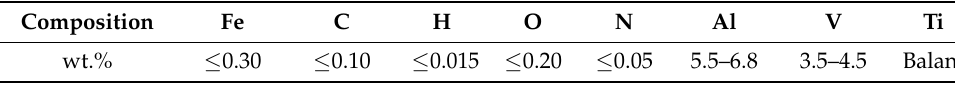
Table 1. Chemical composition of the Ti-6Al-4V alloy.